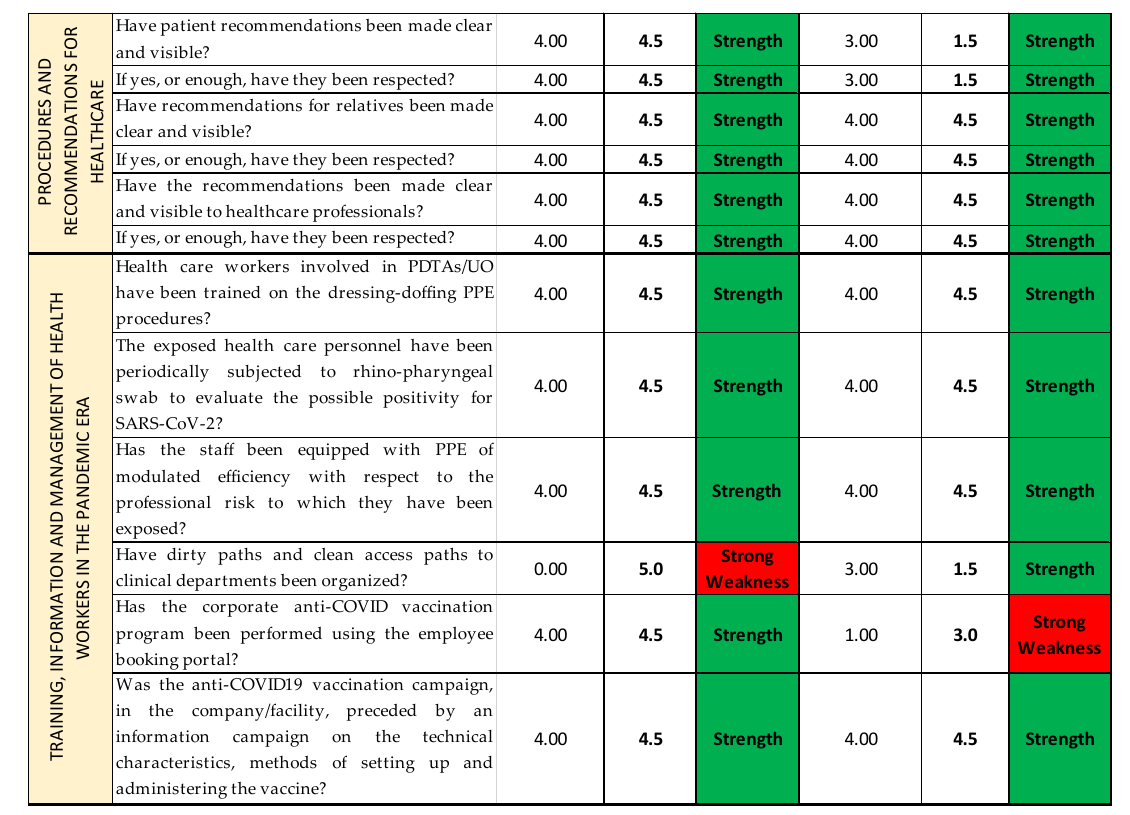
Figure 17. Summary of the results regarding all the items of the four wards analyzed, one for each CP. ( A ) Results of CP1 and CP2. ( B ) Results of CP3 and CP4.